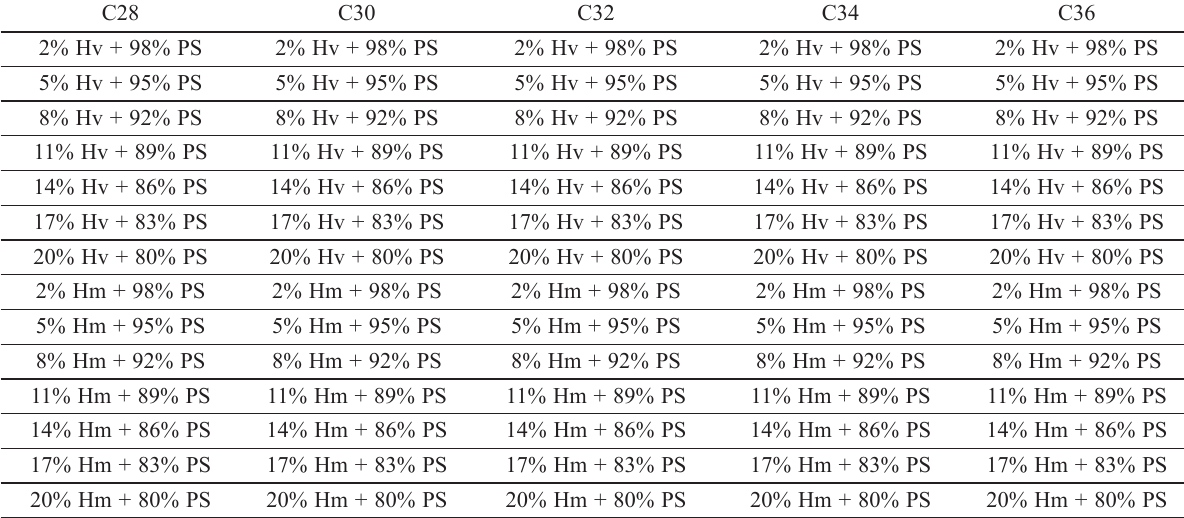
Table 4. Interstitial mediums ( PS: Pore